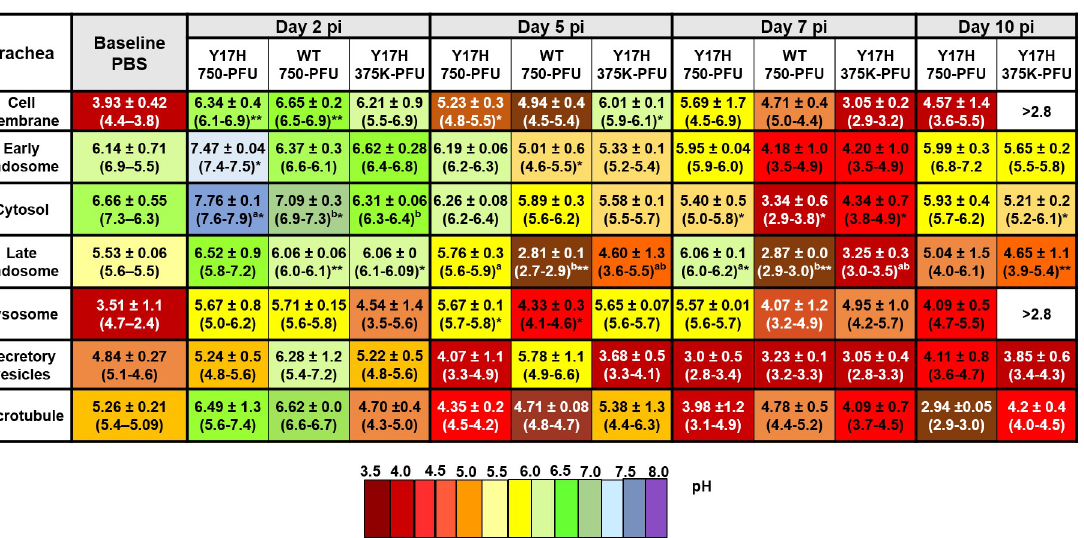
PLOS ONE | https://doi.org/10.1371/journal.pone.0251473 May 12,